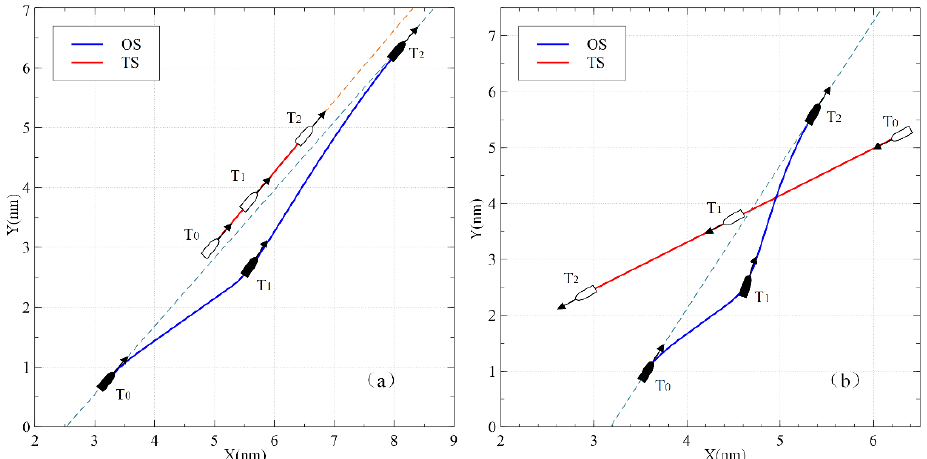
Figure 8. The trajectories of the ships: ( a ) trajectories of the ships in scenario 2; ( b ) trajectories of the ships in scenario 3.